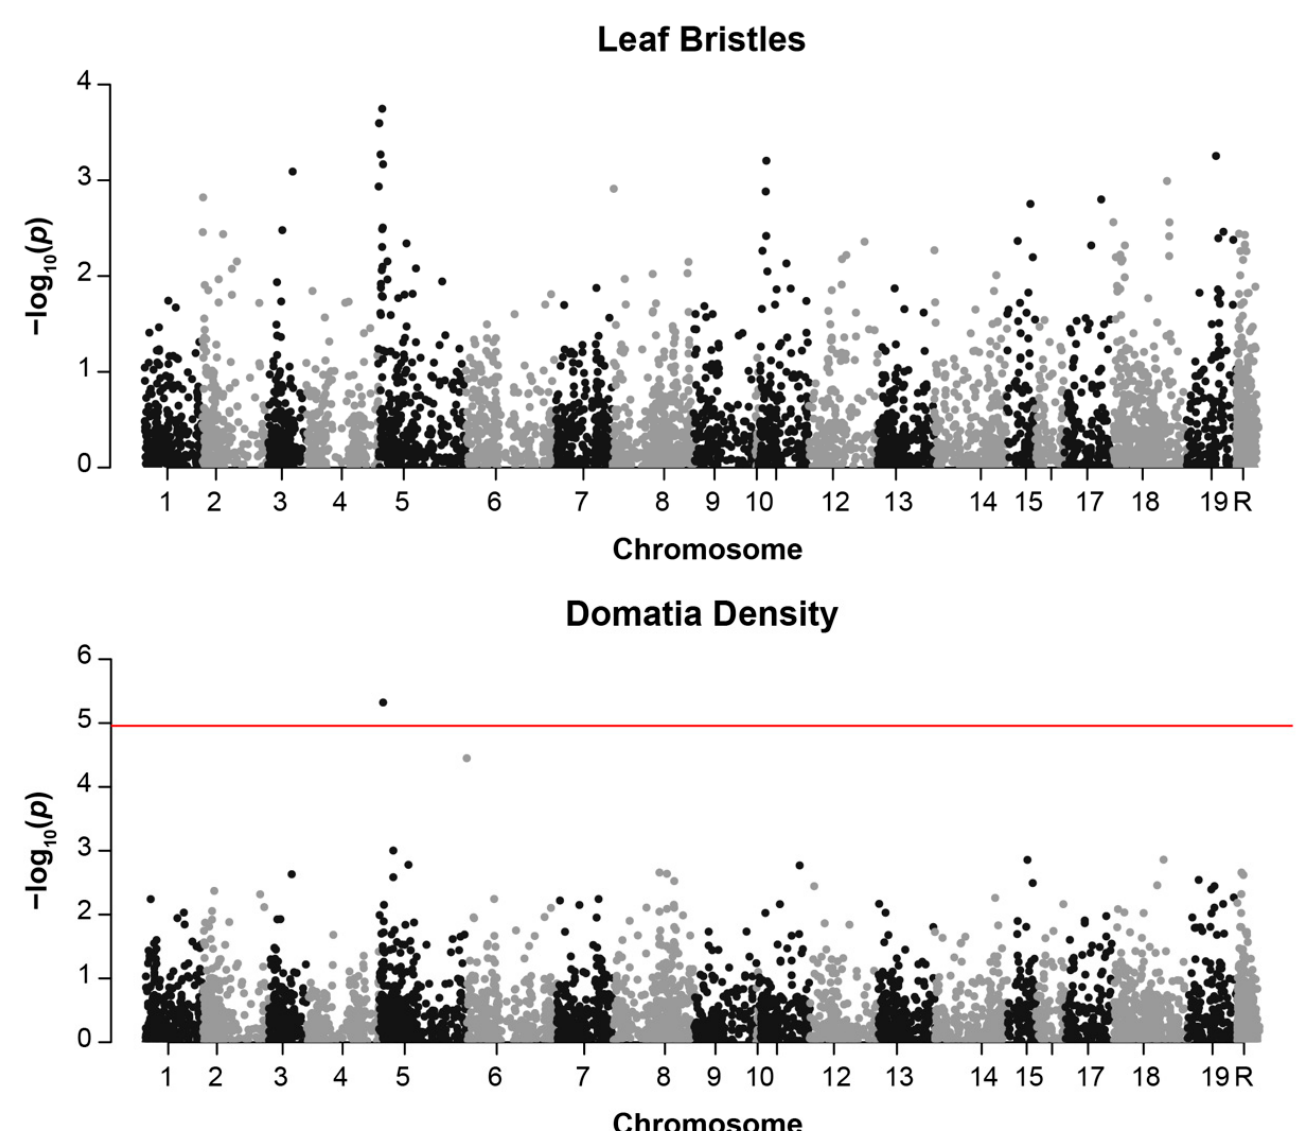
Figure 4. Manhattan plots displaying genome-wide association results for: ( top ) bristle presence/absence and ( bottom ) domatia density. Plots are based on a MLM model with minor allele frequency of >1%. The red line indicates the Bonferroni-corrected threshold for significance with α = 0.05. SNPs on chromosome R are found on contigs that are not anchored to the reference ge- nome.